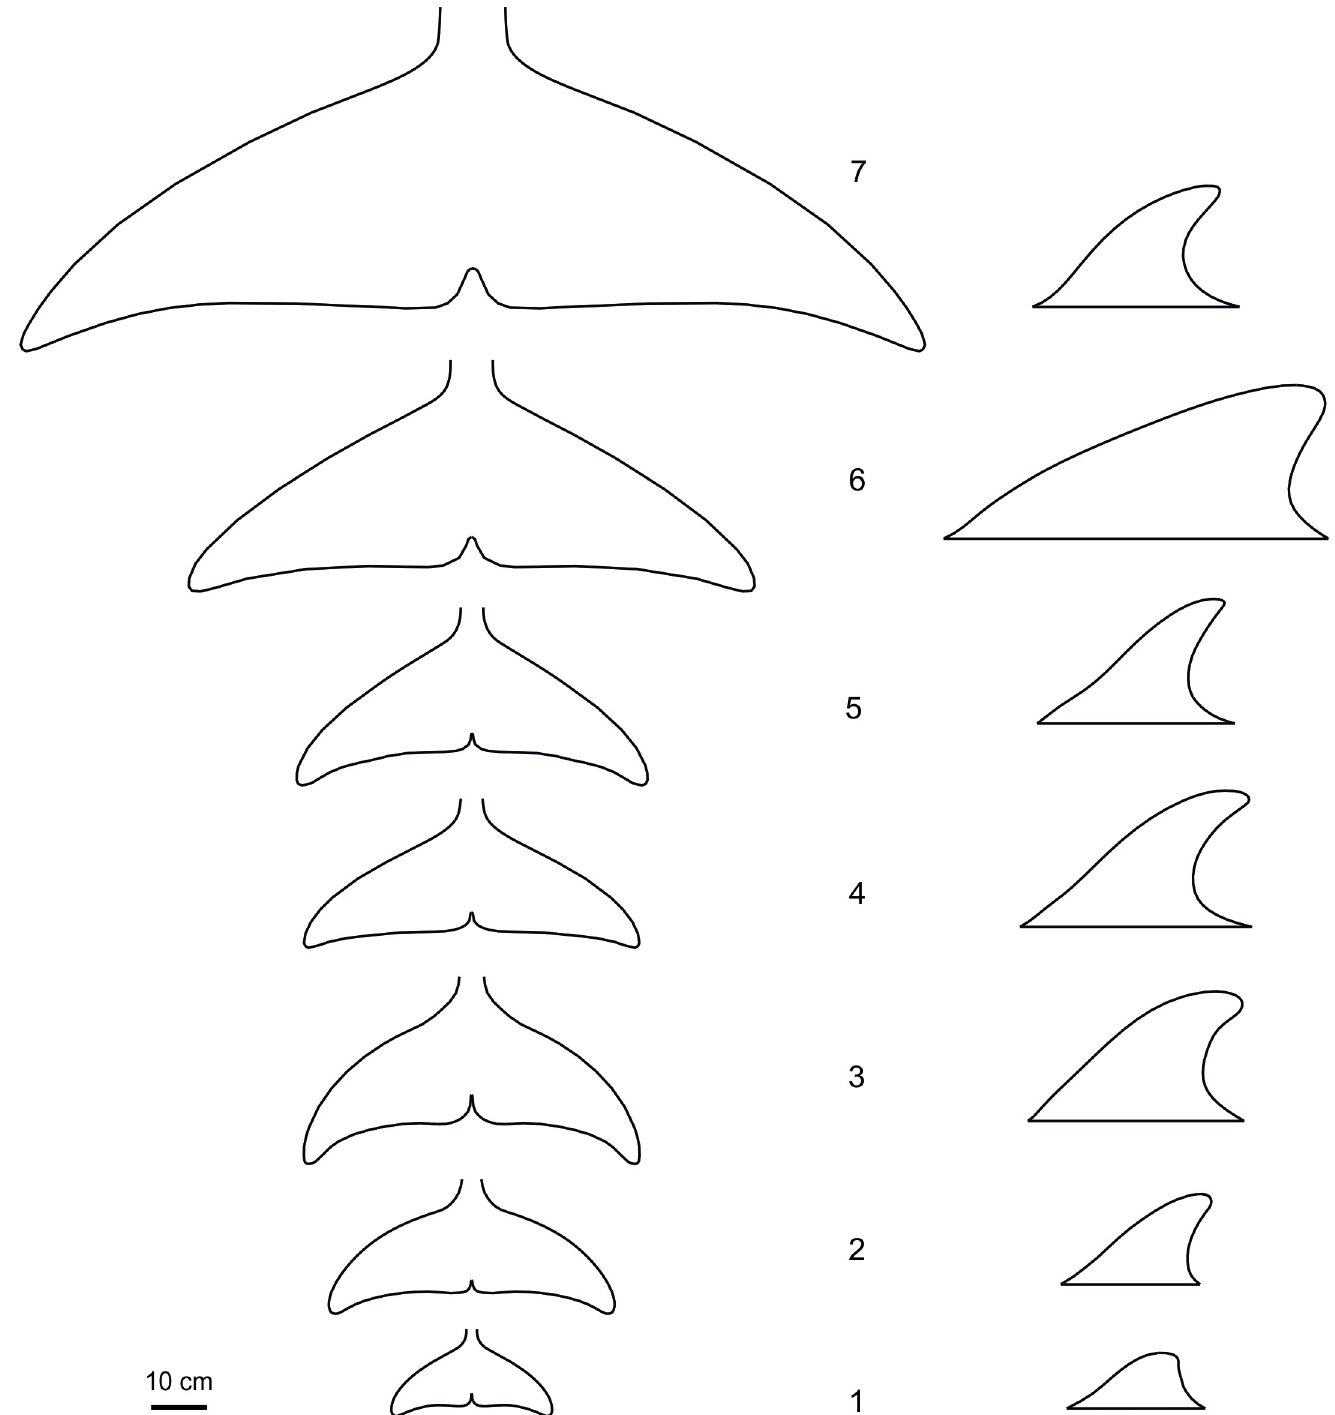
Fig 2. Dorsal fin and tail fluke’s outline. 1 – Phocoena phocoena , 2 – Delphinus delphis , 3 – Tursiops truncatus , 4 – Lagenorhynchus acutus , 5 – Lagenorhynchus albirostris , 6 – Globicephala melas , 7 – Balaenoptera acutorostrata .